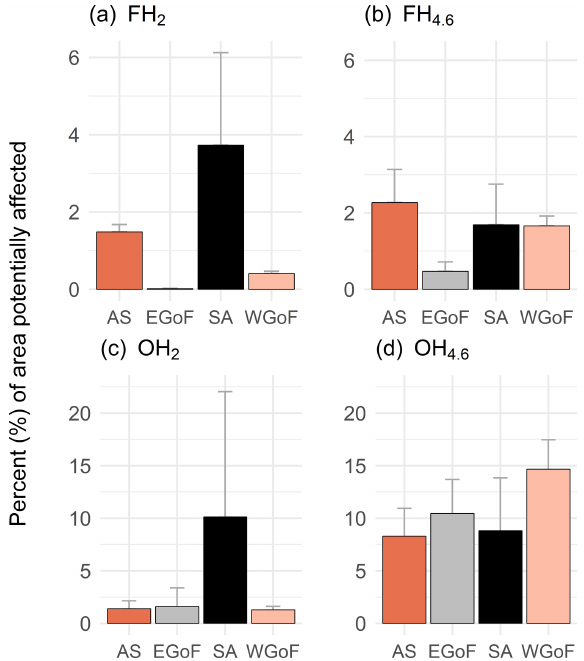
Figure 6. Percent (%) of areas potentially affected by hypoxia with varying frequencies (occasional and frequent) and hypoxia sever- ities (O 2 <4.6 and O 2 <2mgL − 1 ). AS: Archipelago Sea; EGoF: eastern Gulf of Finland; SA: Stockholm archipelago; and WGoF: western Gulf of Finland. GoB is not reported as areas potentially affected were below 2% across all models.